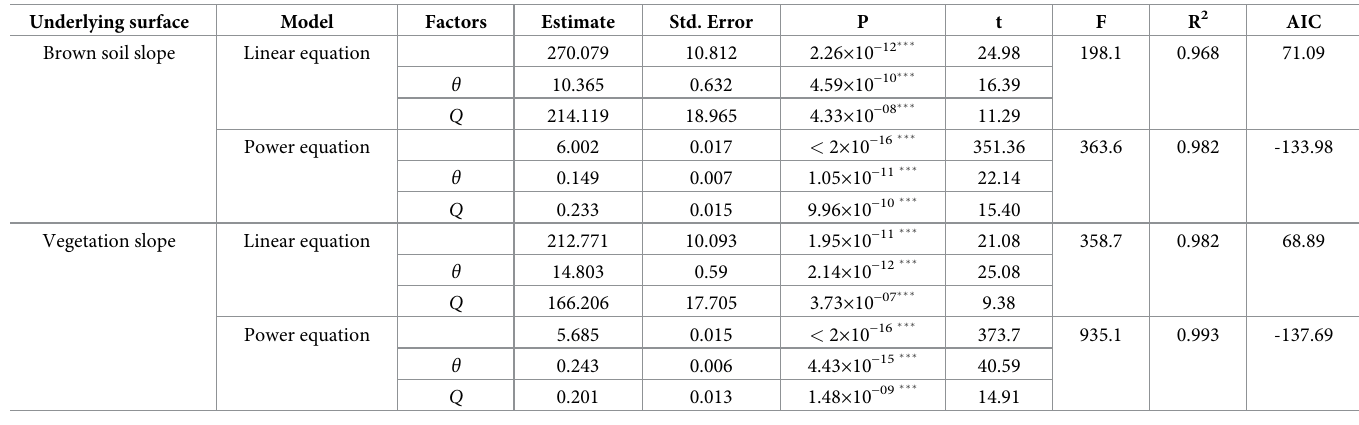
Table 5. Results of stepwise regression analysis. Underlying